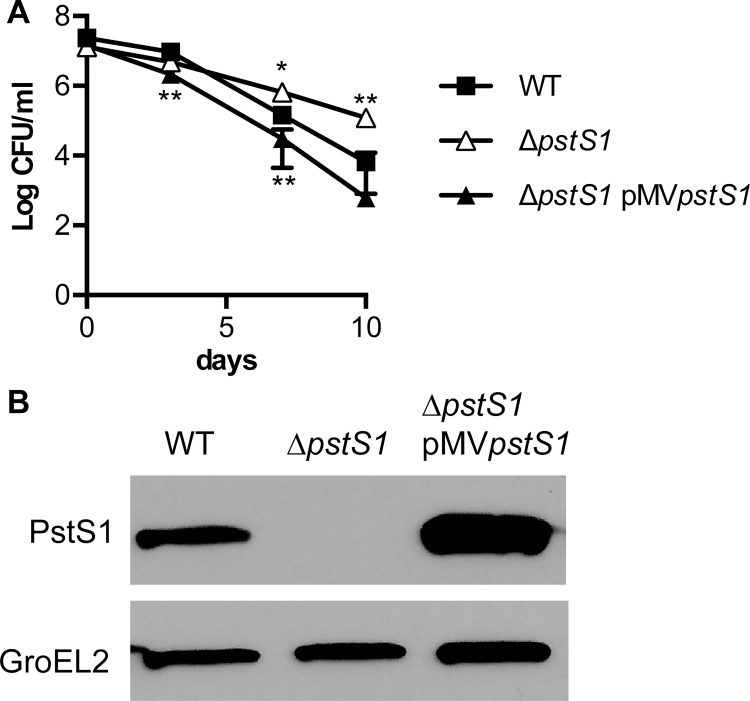
Deletion of pstS1 causes increased resistance to acidified medium.(A) M. tuberculosis WT, ΔpstS1, and ΔpstS1 pMVpstS1 were grown to mid-exponential phase in Pi-rich 7H9 medium and then shifted to acidified 7H9 medium pH 4.5 containing 0.1% Tween-80. Bacterial CFU were enumerated on days 0, 3, 7, and 10 by plating serially diluted cultures on 7H10 agar and incubating for 3 to 4 weeks at 37°C. Data shown are means ± standard deviations of three independent cultures from one experiment and are representative of at least three independent experiments. Asterisks indicate statistically significant differences from the WT control: *P < 0.05, **P < 0.005, ***P < 0.0005. (B) PstS1 protein production. Whole cell lysate proteins (4 μg) of WT, ΔpstS1, ΔpstS1 pMVpstS1 were subjected to SDS-PAGE and Western blot analysis. Mouse monoclonal anti-PstS1 and anti-GroEL2 antibodies were used to detect PstS1 and GroEL2, a cell-associated protein that serves as a loading control. Results shown are representative of two independent experiments.